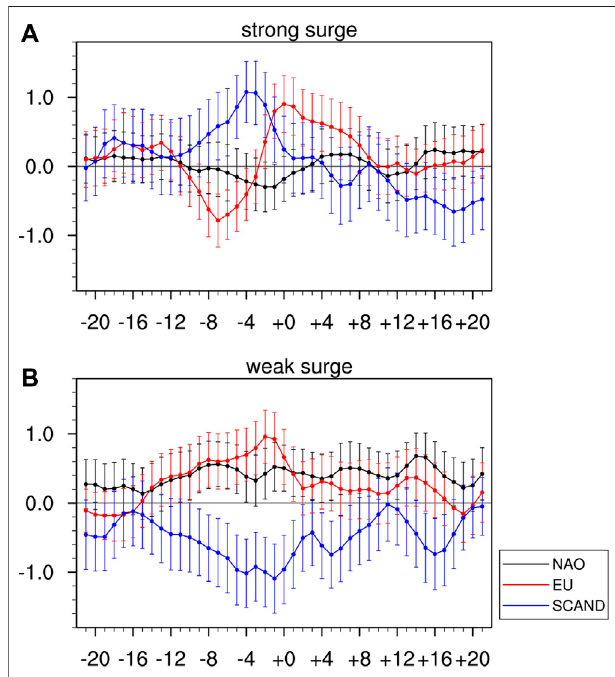
FIGURE8| Asin Figure4 ,but fora (A) strongand (B) weakcoldsurge.